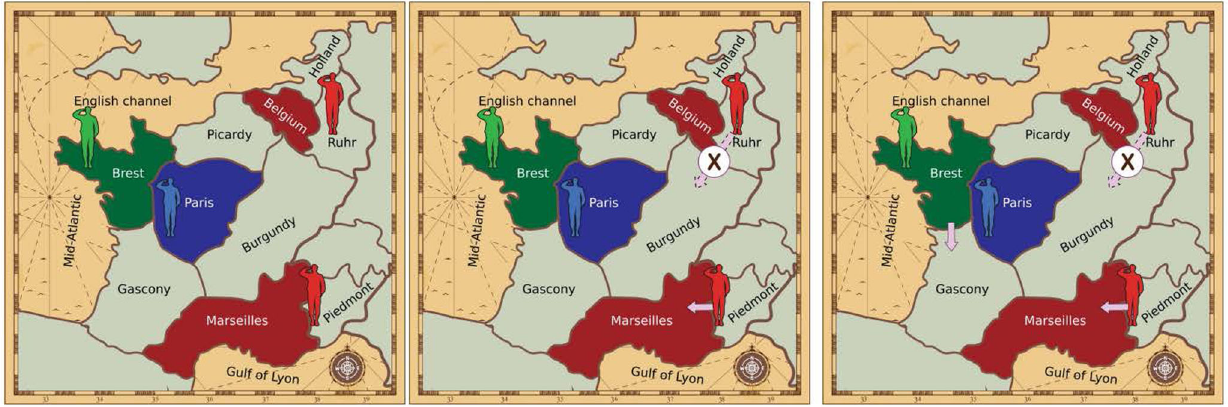
Fig. 2 | Diplomacy contracts. Left: a part of the Diplomacy board with three players. Middle: a restriction allowing only certain actions R Red to be taken by the Red player; in this example, the unit in Ruhr may not move to Burgundy, while the unitinPiedmontmustmove to Marseilles.The set R Red consists onlyof the actions